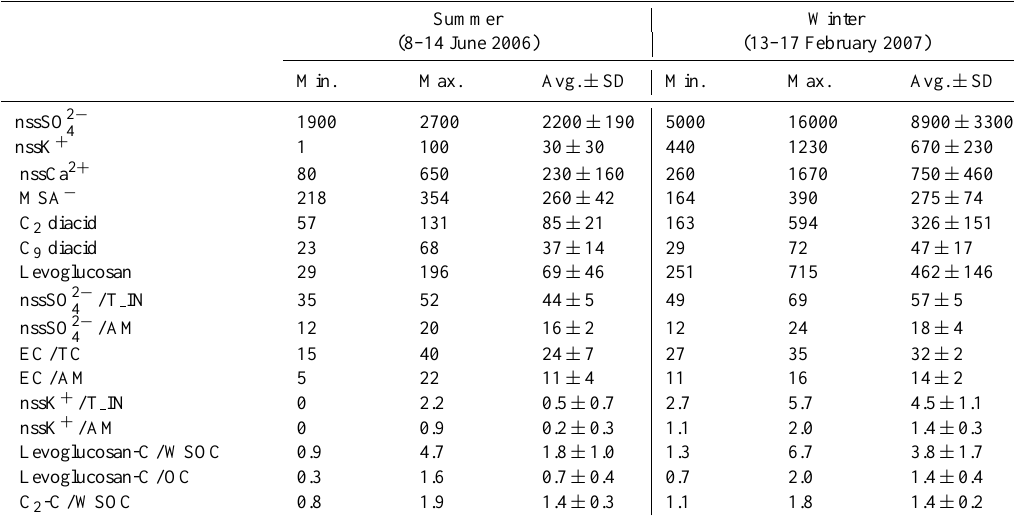
Table 2. Selected marker species (ngm − 3 ) and their ratios (%) to different aerosol components determined in the Mumbai aerosol samples (PM 10 )